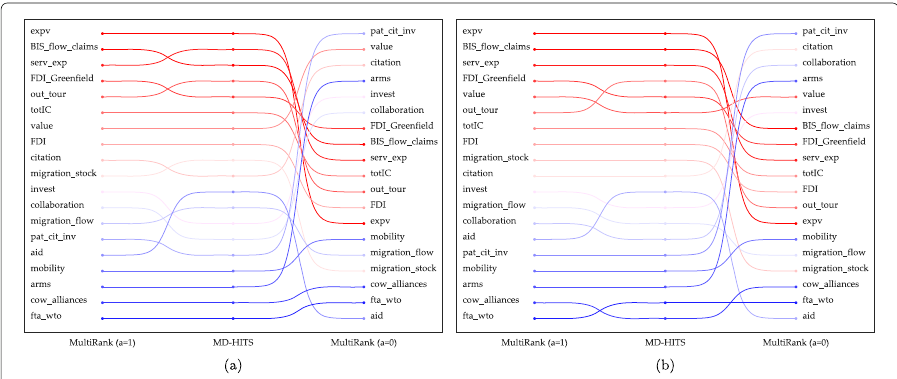
Fig. 5 Layer rankings in different configurations: cross section 2003 ( a ), cross section 2010 ( b ). For the MultiRank rankings the other parameters are in both cases s = 1 and γ =